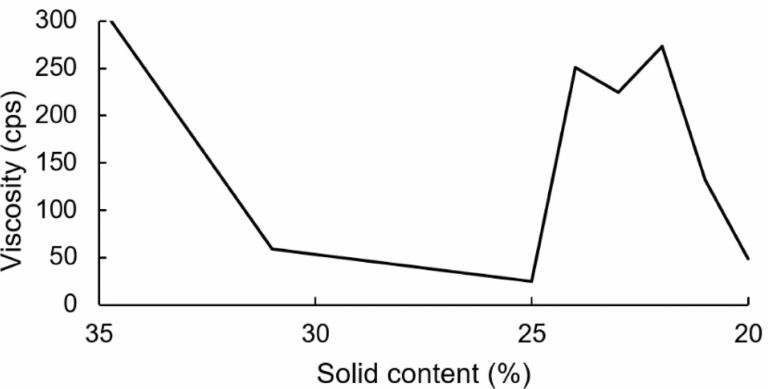
Figure 10. Viscosity variations of IPDI-containing ionomer during water dispersion process.